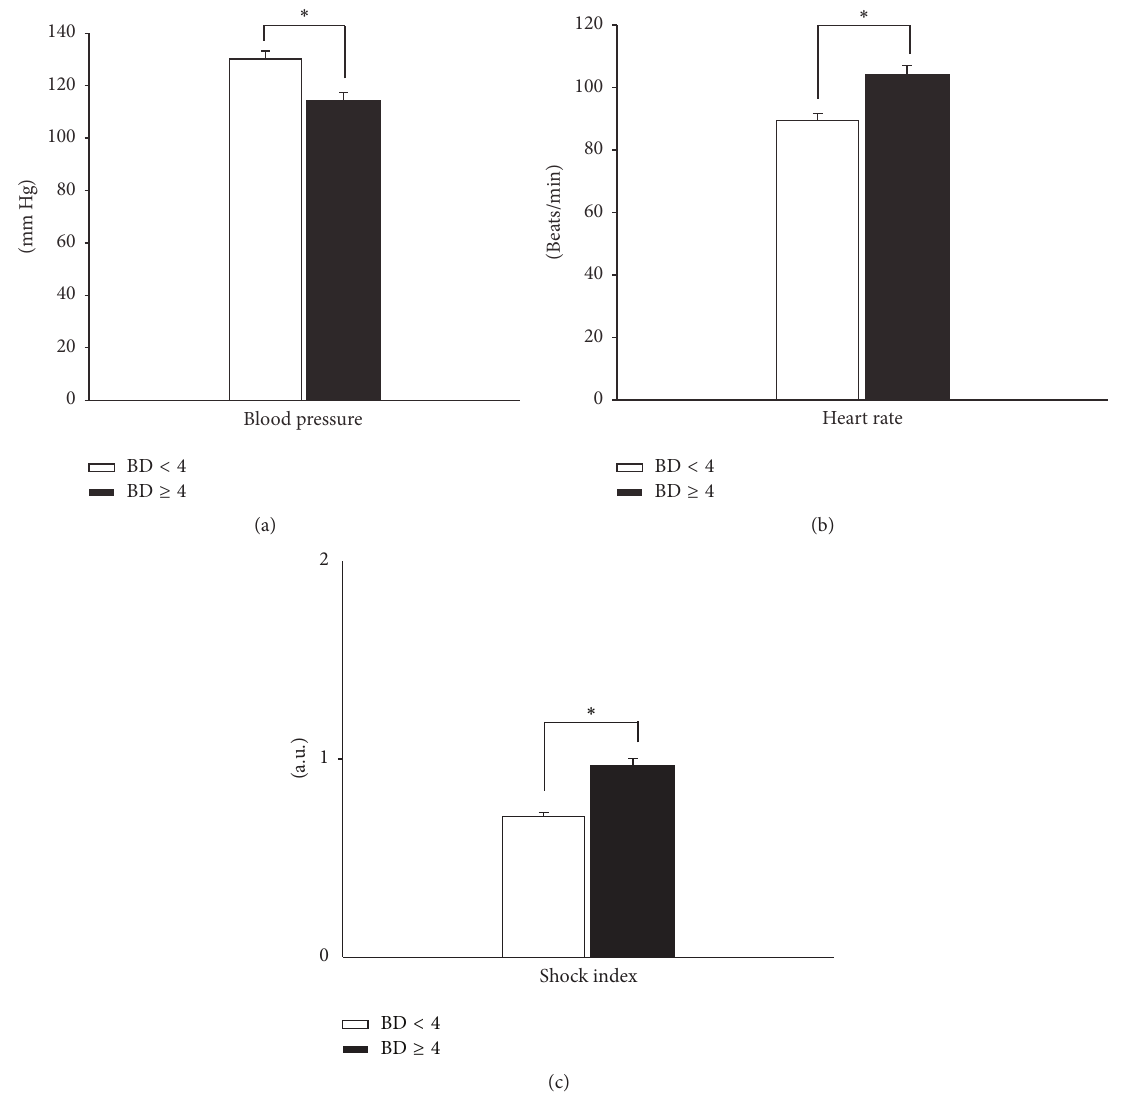
Figure 2: (a) Differences in (a) admission systolic blood pressure (SBP), (b) admission heart rate (HR), and (c) Shock Index between BD ≥ 4 and BD < 4 subgroups. (a) Admission SBP, (b) admission HR, and (c) Shock Index (HR/SBP) were statistically significantly different in the BD ≥ 4 group when compared to the BD < 4 group. ∗ 𝑃 < 0.05 by Mann–Whitney U